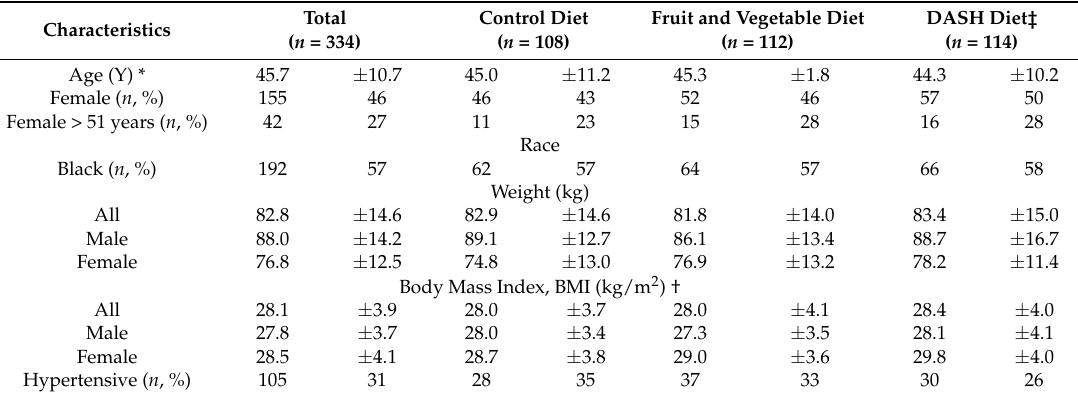
Table 1. Baseline characteristics of the study participants, per dietary